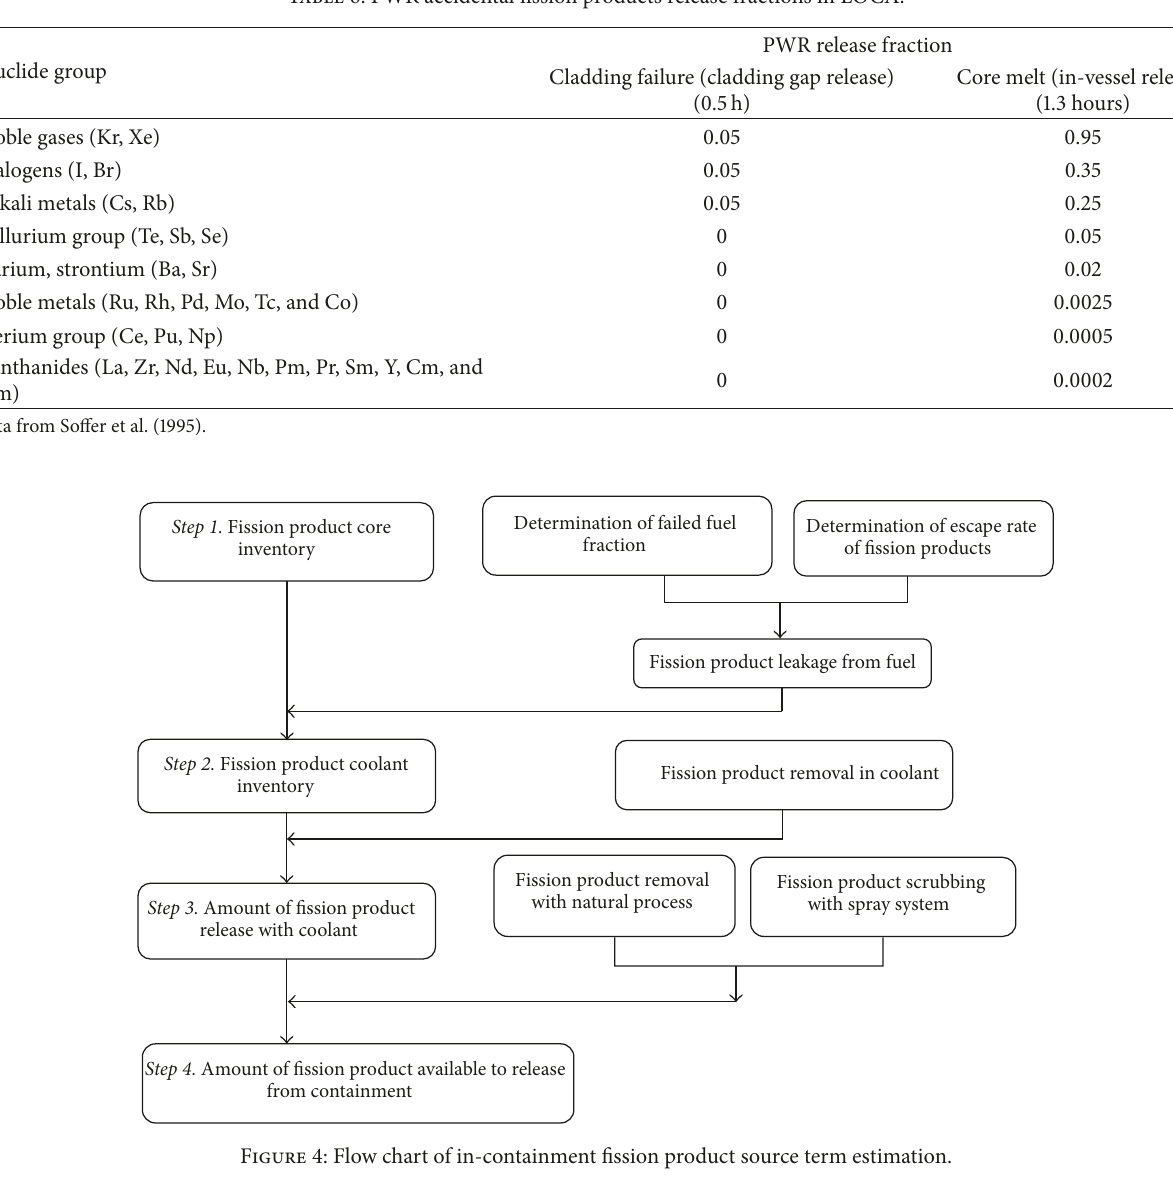
Table 6: PWR accidental fission products release fractions in LOCA.